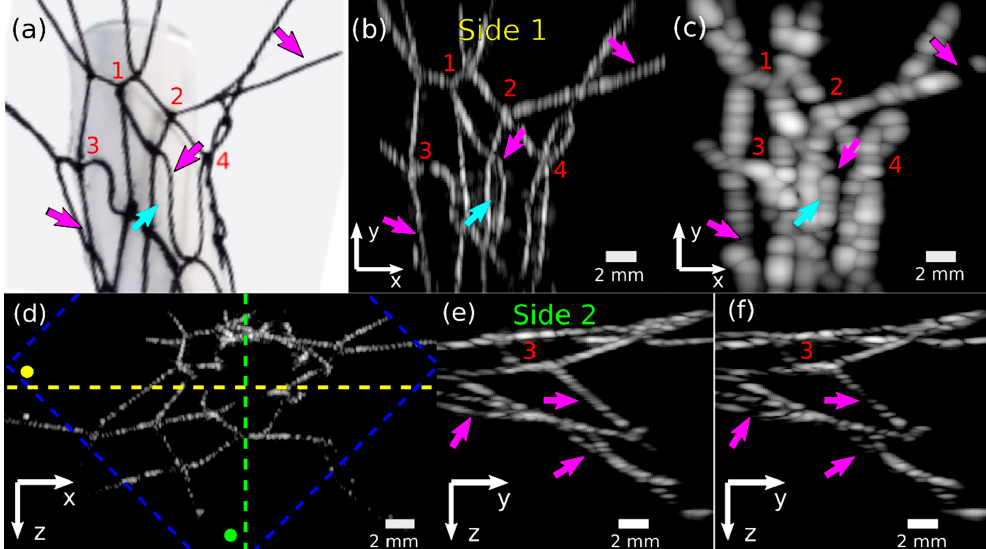
Figure 10. Images of a 3-D net. ( a ) Optical picture of the top of phantom Ph4. A paper cylinder was inserted in the net to mask the lower part; ( b , d , e ) display of a volumetric image of Ph4 for a rotate-translate scan at Δ α 2 with a steered transmit; ( b ) MAP image along z-axis of the top part of the volumetric image (part of the volume with z-coordinates smaller than the yellow dotted line in ( d )); ( d ) MAP image along y-axis; ( e ) MAP image along x-axis of the left part of the volume (part of the volume with x-coordinates smaller than the green dotted line in ( d )). The voxels outside of the DSCA were discarded for the MAP for ( b , e ); ( c , f ) display images extracted from the volumetric rendering of Ph4 for a translation-only scan; ( c ) MAP image along z-axis for the same volume as ( b ); ( f ) MAP image along x-axis for the same volume as ( e ); the color scale for ( b – f ) is between − 30 and 0 dB. Knots are identified with numbers that serve as landmarks. Pink arrows indicate threads that appear discontinuous in the image for the translation-only scan and are better mapped with the rotate-translate scan.